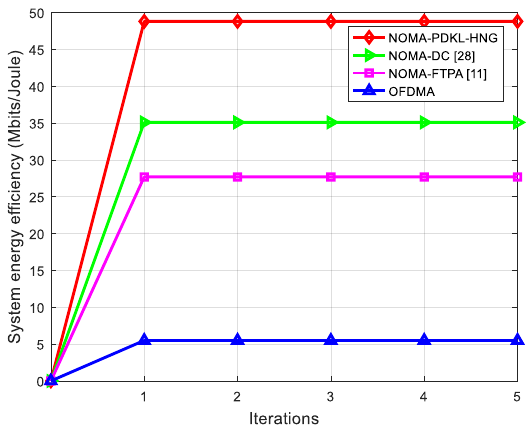
Figure 9. System energy efficiency vs. iterations.